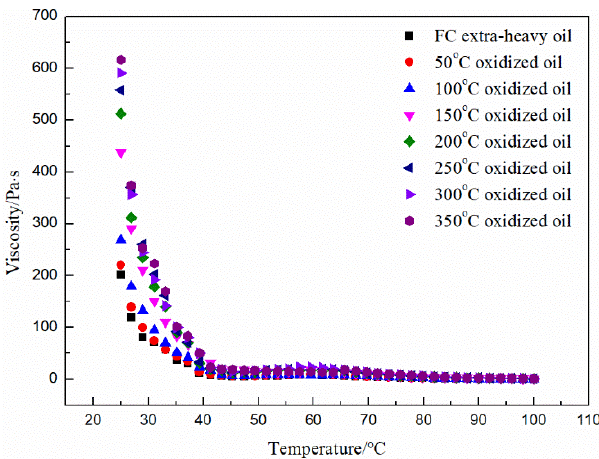
Figure 2. Changes in gas content of gaseous products.